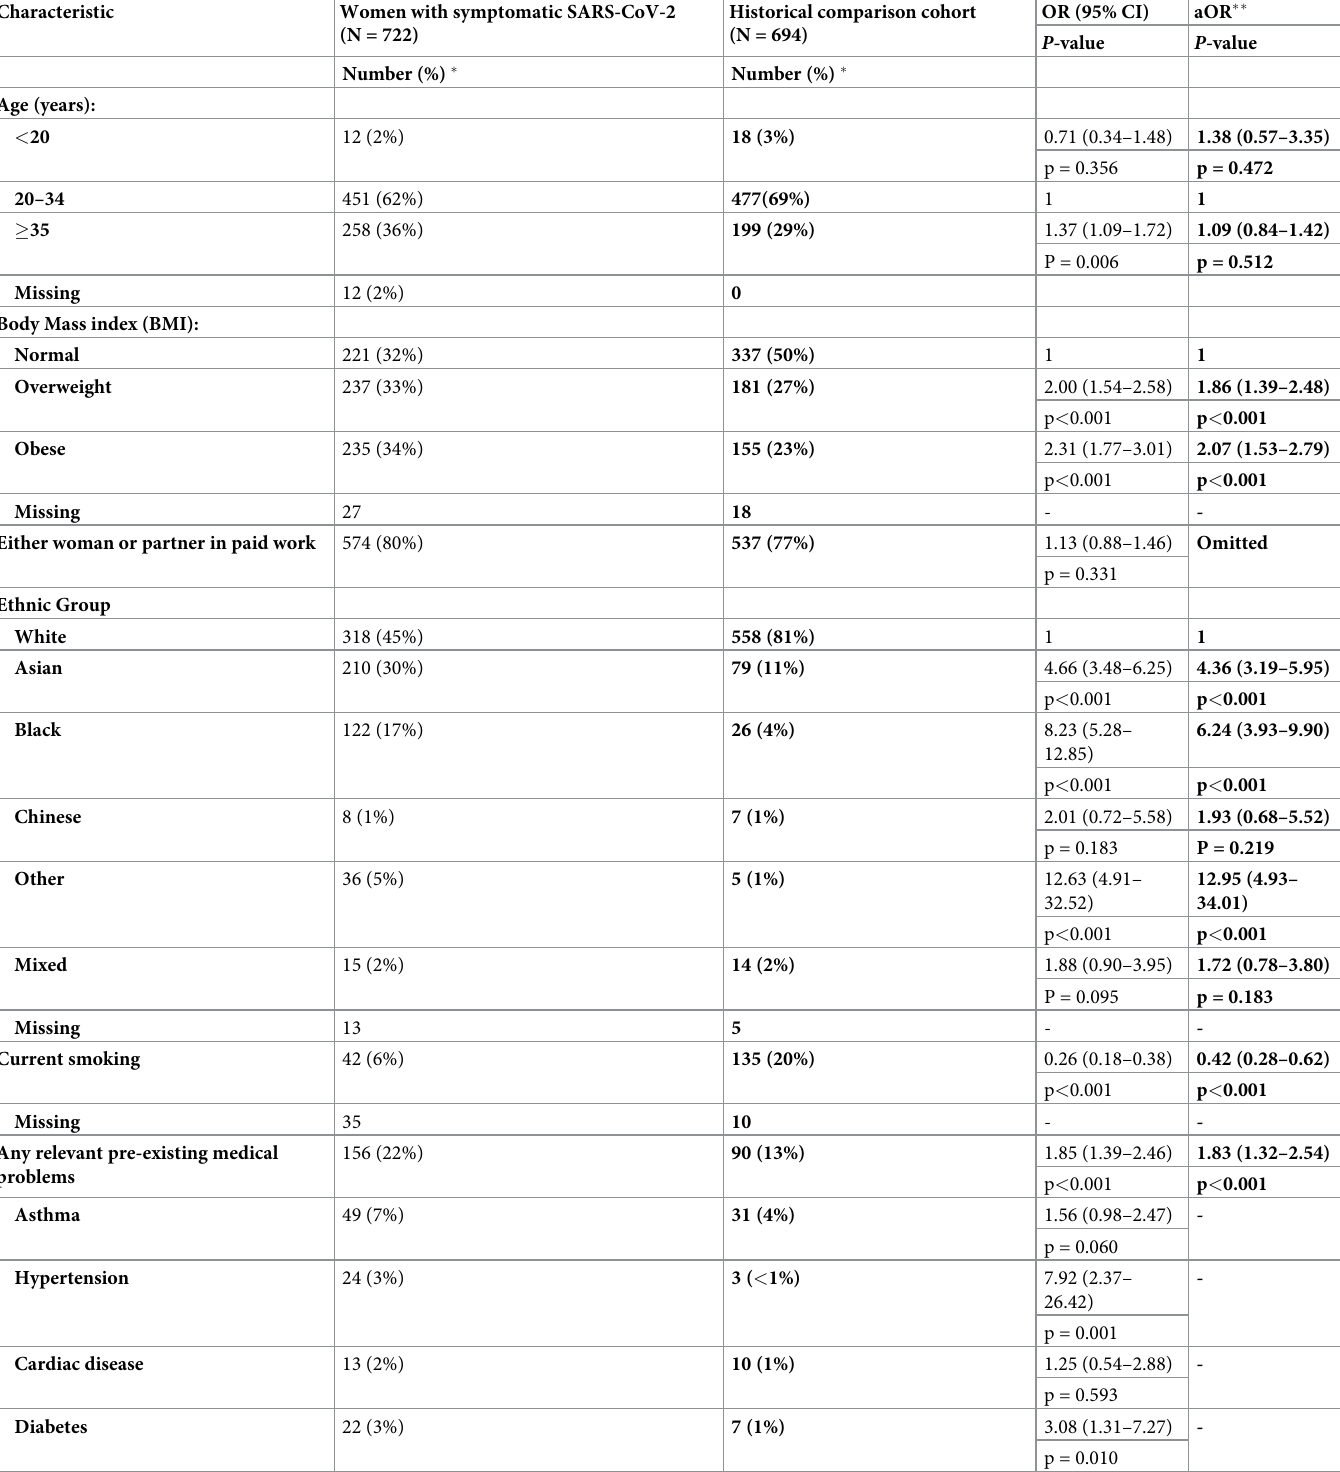
Table 1. Characteristics of pregnant women with symptomatic confirmed SARS-CoV-2 infection admitted to hospital in the UK compared to a historical cohort without SARS-CoV-2